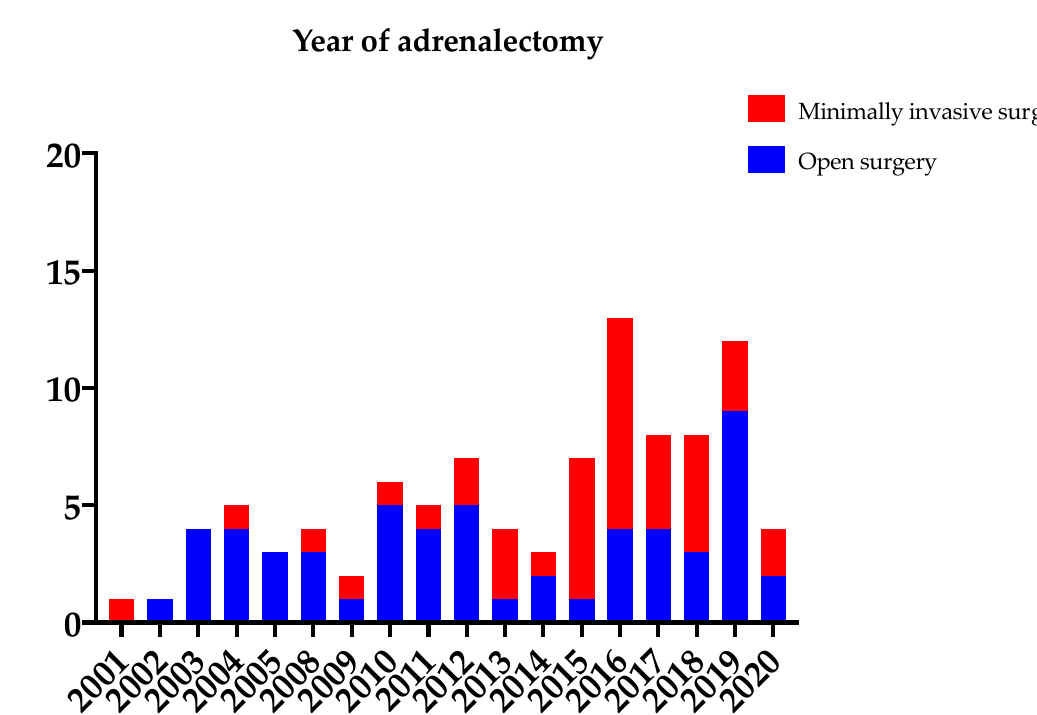
Figure 2. The number of adrenalectomies for adrenal metastasis performed per year per type of surgery.